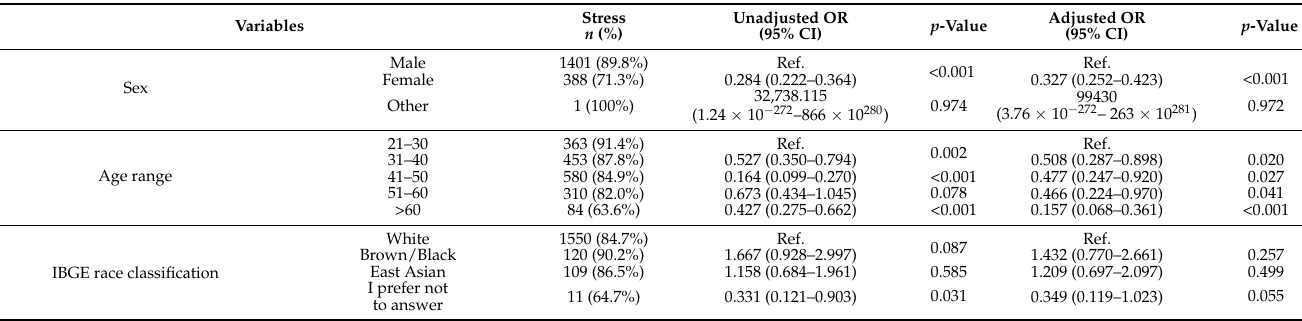
Table 3. Descriptive and logistic regression analysis (odds ratio; 95% confidence interval) of stress and independent